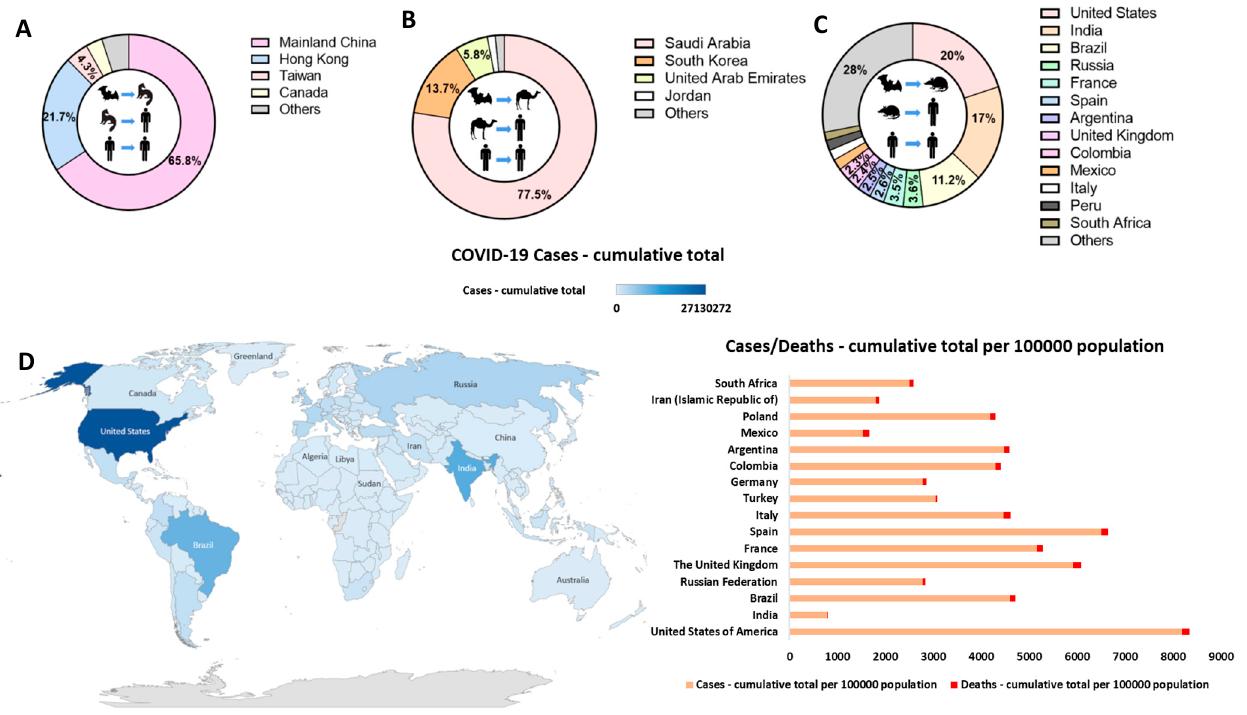
Figure 1. The transmission patterns and countries with the highest proportion of coronavirus diagnoses. Transmission patterns for ( A ) SARS-CoV-1, ( B ) MERS-CoV and ( C ) SARS-CoV-2 and countries with the largest proportions of confirmed cases are shown separately. ( D ) The COVID-19 cases and deaths—cumulative total per 100,000 population for countries with the largest proportions of confirmed cases. (The datasets analysed in this figure are available on the WHO website WHO | World Health Organization).